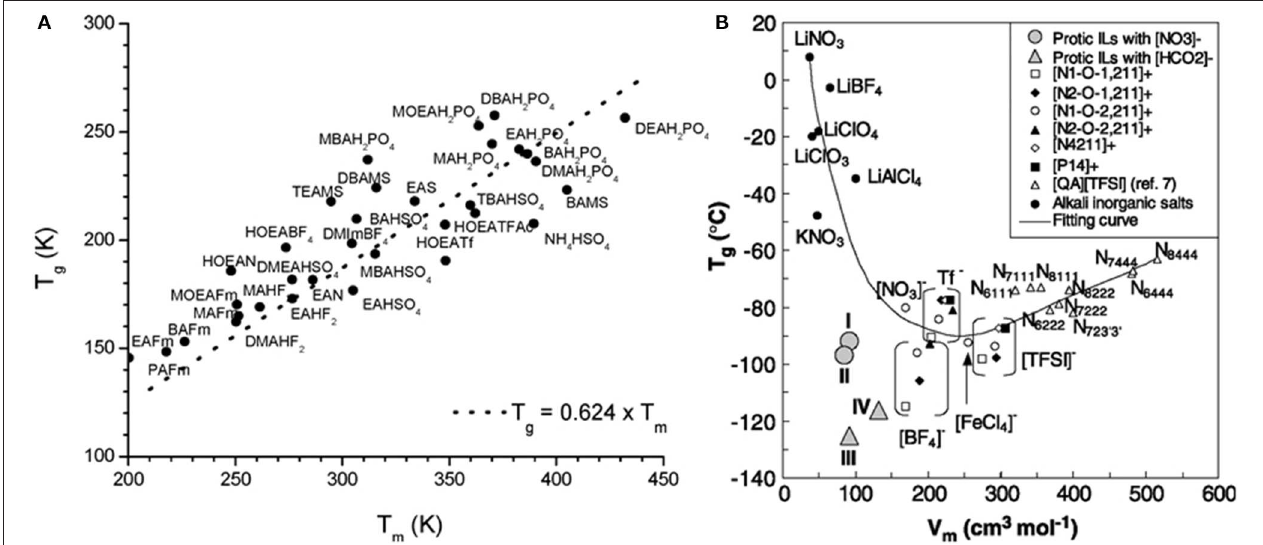
Frontiers in Chemistry |